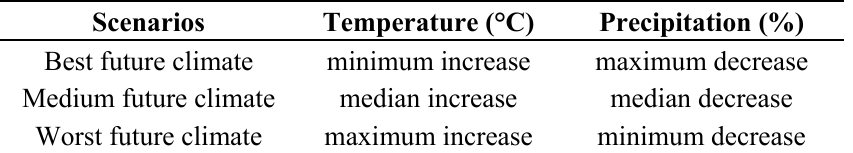
(Table 1): A best-case, a medium-case and a worst-case climate scenario, for which we combined the minimum, median and maximum temperature and precipitation response projections provided in Christensen [10] in Table 11.1. Table 1. Created future climate scenarios for